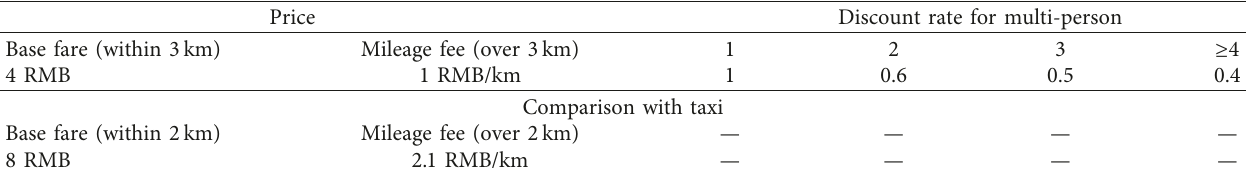
Figure 12: Spatial distribution of passenger flow. (a) OD bar chart, (b) OD distribution. Table 3: Fare rule of bus sharing and taxi.